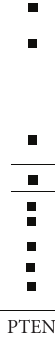
Figure 2: The mRNA expression levels of PTEN and MMP9 in 16 human grade III astrocytoma samples (AA). Bold horizontal lines represent the mean values, and thin lines represent the mean normal brain cortex samples (NB)